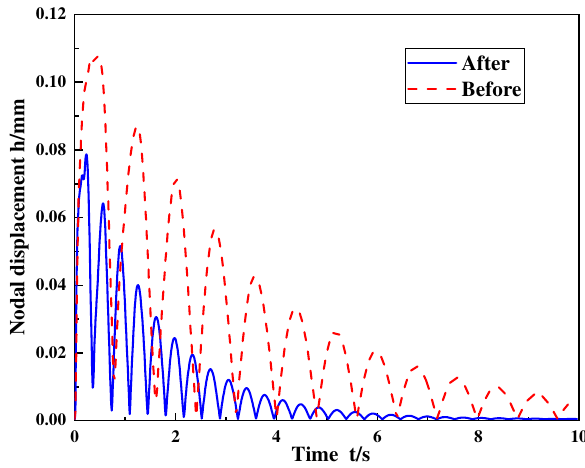
Figure 12. Displacement curve of the foundational node.